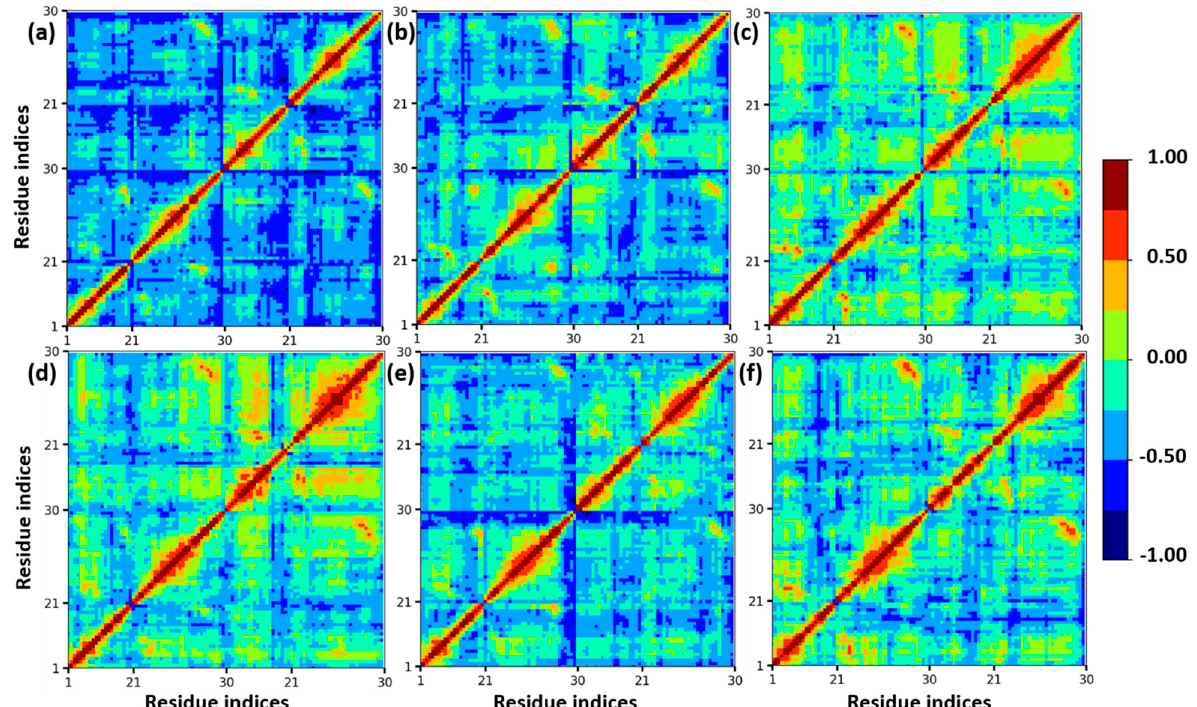
Figure 3. Calculated DCCM plots of insulin C − alpha atoms with different mole fractions of EtOH: ( a ) insulin–water, ( b ) 0.20, ( c ) 0.40, ( d ) 0.60, ( e ) 0.80, and ( f ) 1.00 mole fractions of EtOH. Color codes from red to blue represent the correlated and anti-correlated motions.